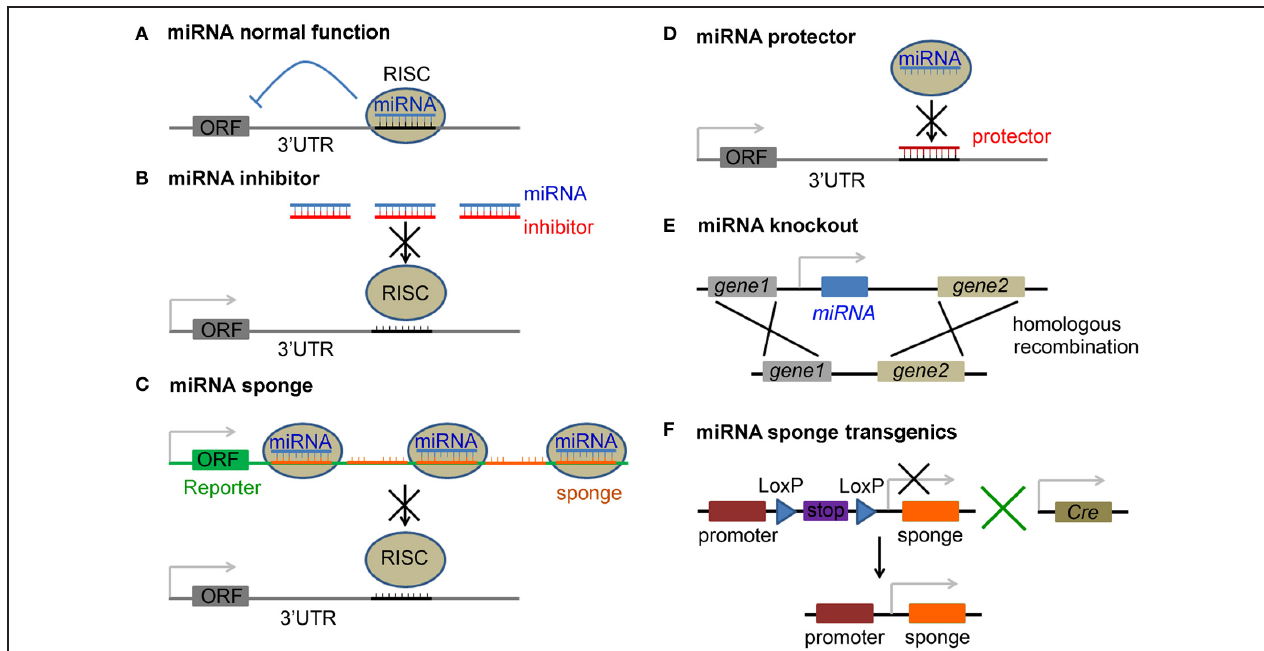
saturated by miRNA sponges that carry tandem multiplex of complementary sequences, which usually imperfectly match the target miRNA and are inserted in the 3 (cid:2) UTR of a reporter gene. (D) mRNA protector functions by a perfect binding to the 3 (cid:2) UTR of a mRNA and protects it from being bound by its miRNA. (E) Loss-of-function of a miRNA is achieved by direct miRNA knockout from the genome. (F) Tissue specific blockage of miRNA activity is achieved by breeding floxed miRNA sponge transgenic mice (with a stop signal flanked by two LoxP sites) with a proper Cre